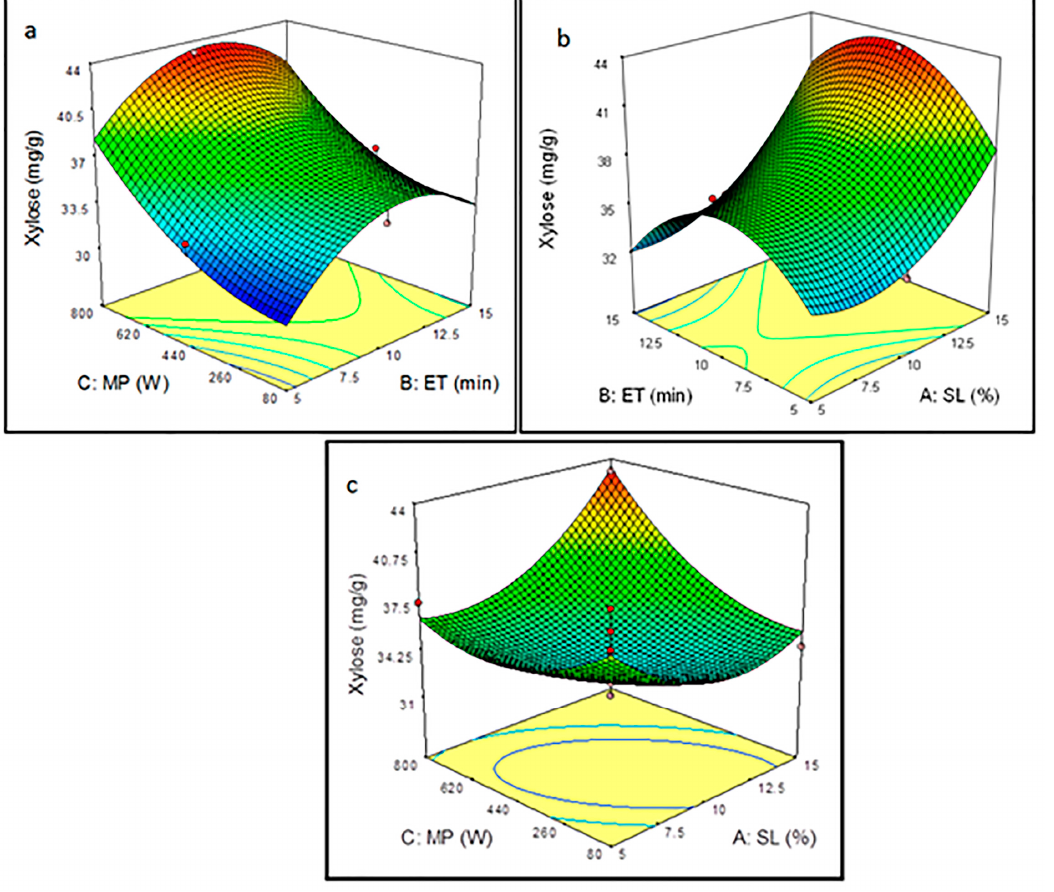
Figure 5. The effect of pretreatment parameters of MSA pretreatment on the xylose yield ( a ) with MP and ET at a constant SL, ( b ) with ET and SL at a constant MP, and ( c ) with MP and SL at a constant ET.